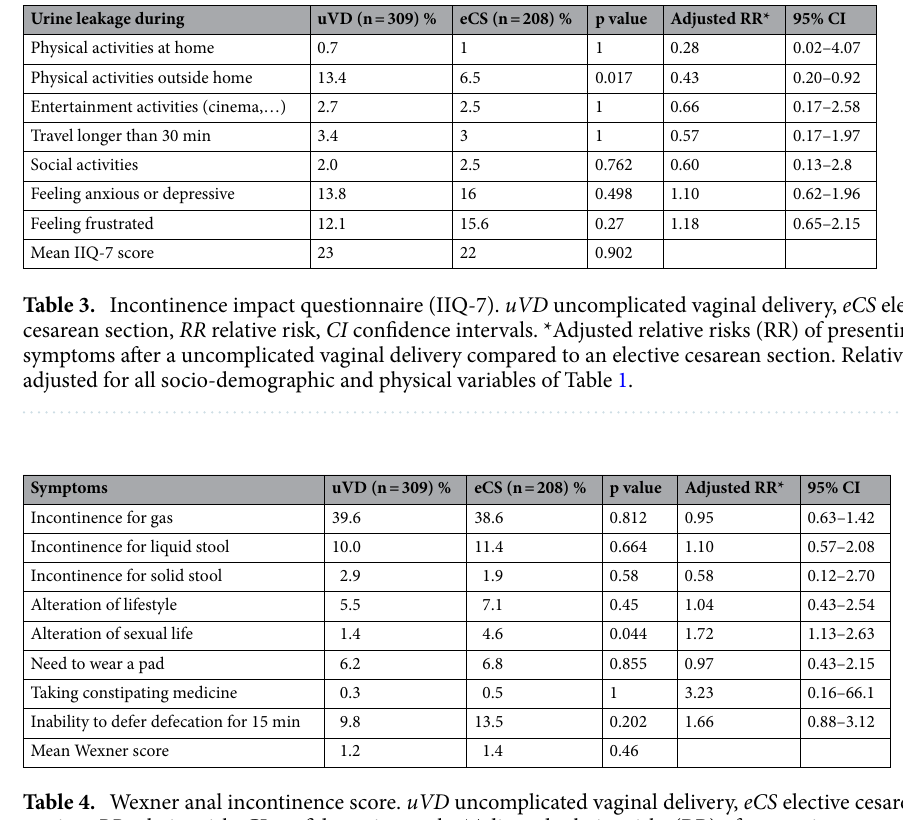
Table 4. Wexner anal incontinence score. uVD uncomplicated vaginal delivery, eCS elective cesarean section, RR relative risk, CI confidence intervals. *Adjusted relative risks (RR) of presenting symptoms after a uncomplicated vaginal delivery compared to an elective cesarean section. Relative risks were adjusted for all socio-demographic and physical variables of Table 1.